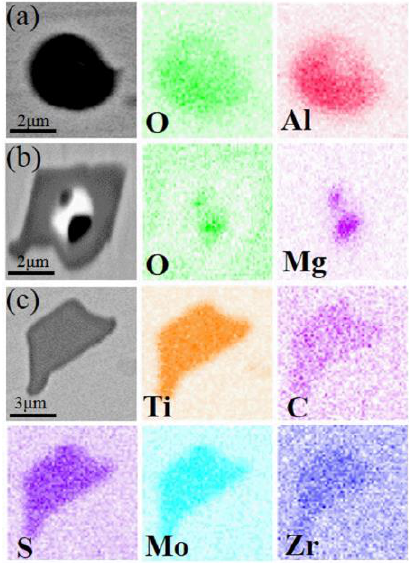
Figure 5. SEM images and EDS maps of other inclusions in ingot #1: ( a ) Al 2 O 3 ; ( b ) MgO; and ( c ) Ti ‐ Mo ‐ Zr ‐ C ‐ S.